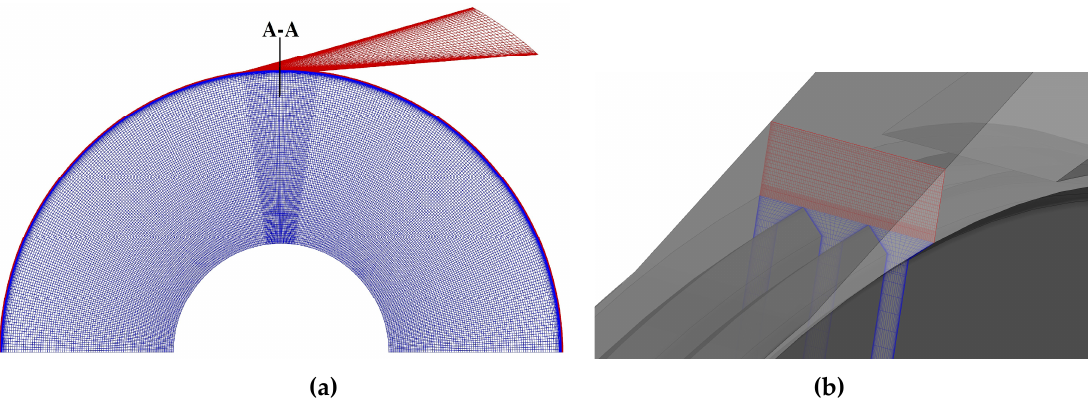
Figure 6. Calculation grid for OTM-T-2. ( a ) Overall grid; ( b ) Detailed grid at A-A section